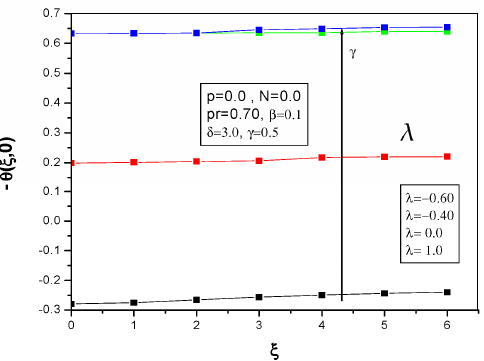
Figure 15. Effect of the temperature exponent and buoyancy force parameter on Nusselt number.